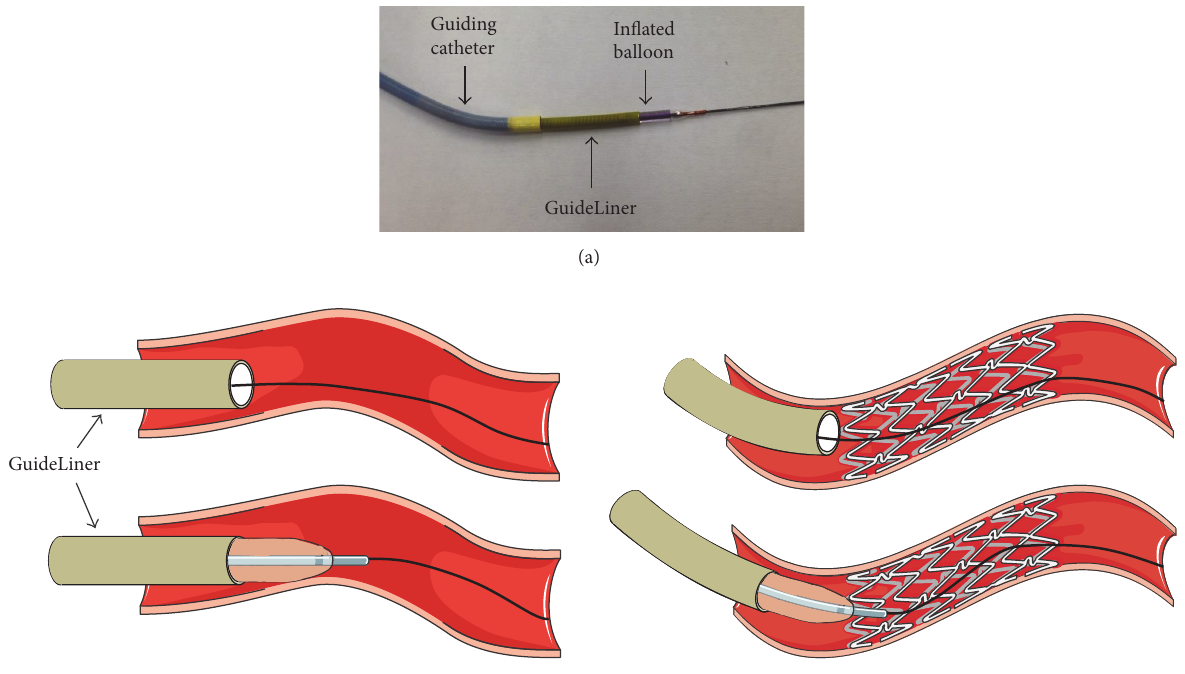
Figure 1: GuideLiner Balloon Assisted Tracking technique. (a) In the image a 6Fr. GuideLiner is shown with a protruding compliant 2.0mm × 15 mm balloon. (b) Advancement of the GuideLiner through a tortuous vessel with the compliant balloon at the tip of the GuideLiner. (c) Advancement of the GuideLiner in previously stented segments with the leading balloon tip.